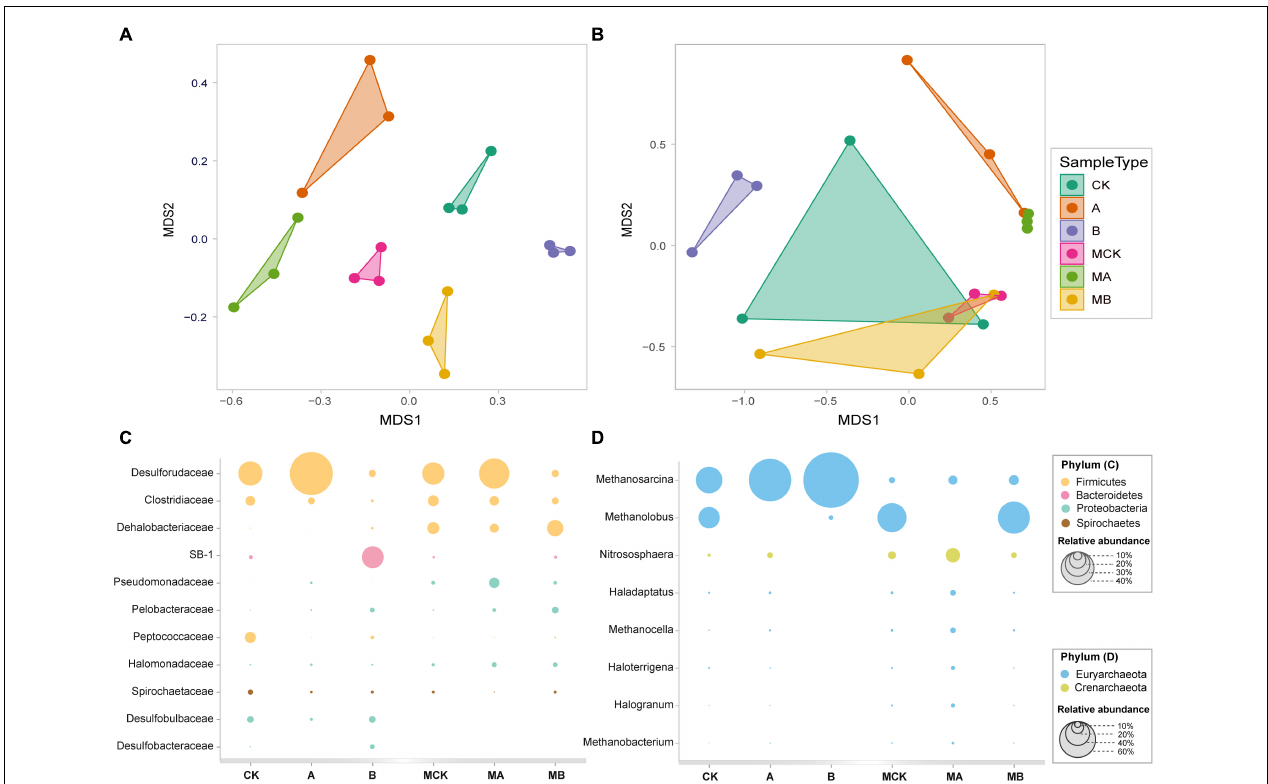
FIGURE 3 | The NMDS plots based on generalized UniFrac distance for bacterial (A) and archaeal (B) community structure, respectively, and the relative abundance of dominant bacterial community at family level (C) and archaeal community at genus level (D) in different